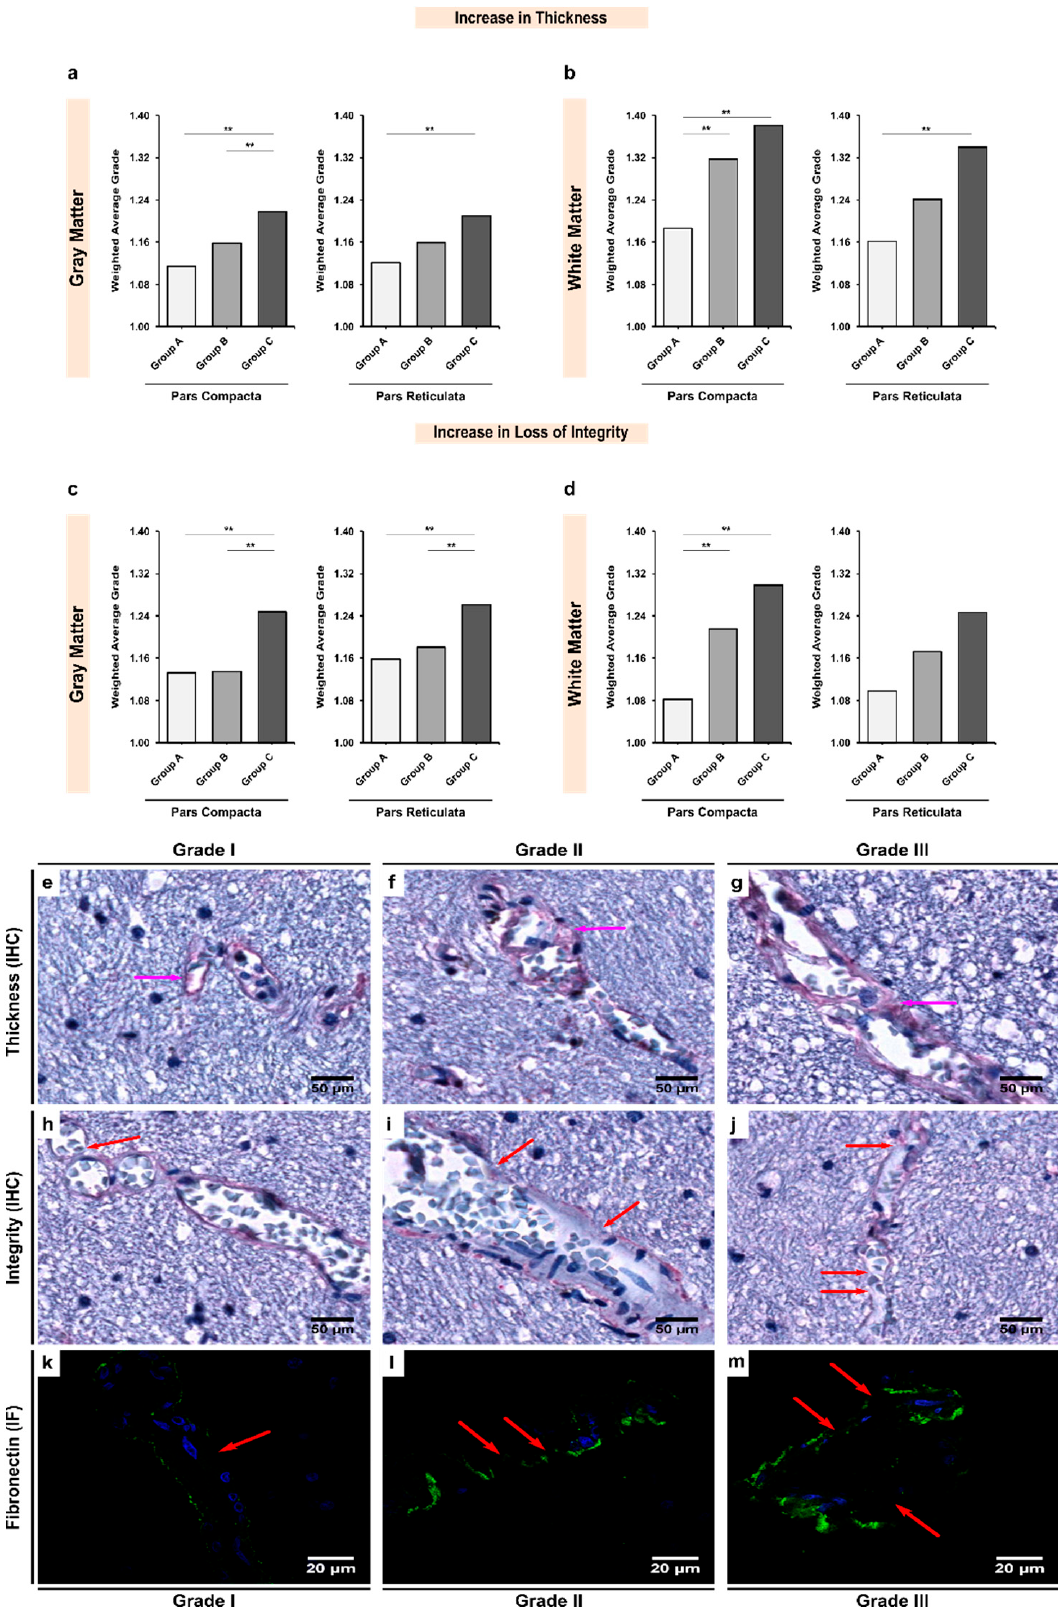
Figure 5. Inter-group analysis of the increase in ( a , b ) thickness and ( c , d ) loss of integrity of the BM based on the expression of fibronectin in the microvessels in the ( a , c ) gray matter and ( b , d ) white matter of the SN region. Group A represent controls, group B represents young alcoholics, whilst group C represents chronic alcoholics. The bar plots indicate the weighted average grading of all the visualized blood vessels in each group; ** indicates a significant difference between the groups ( p < 0.05 with Bonferroni correction is considered as significant). Representative photomicrographs showing the different grades of BM thickness and integrity based on expression of fibronectin as visualized in the brain tissue material using immunohistochemistry (IHC) and immunofluorescence (IF) as follows: ( e , h , k ) grade I vessel with normal (baseline) thickness and unchanged integrity; ( f , i , l ) grade II vessel with a moderate thickness and damaged integrity; ( g , j , m ) grade III vessel with extremely thickened and split BM. The pink and red arrows show the extent of thickening and loss of integrity as visualized using IHC and IF, respectively. In IF, green color shows the fibronectin